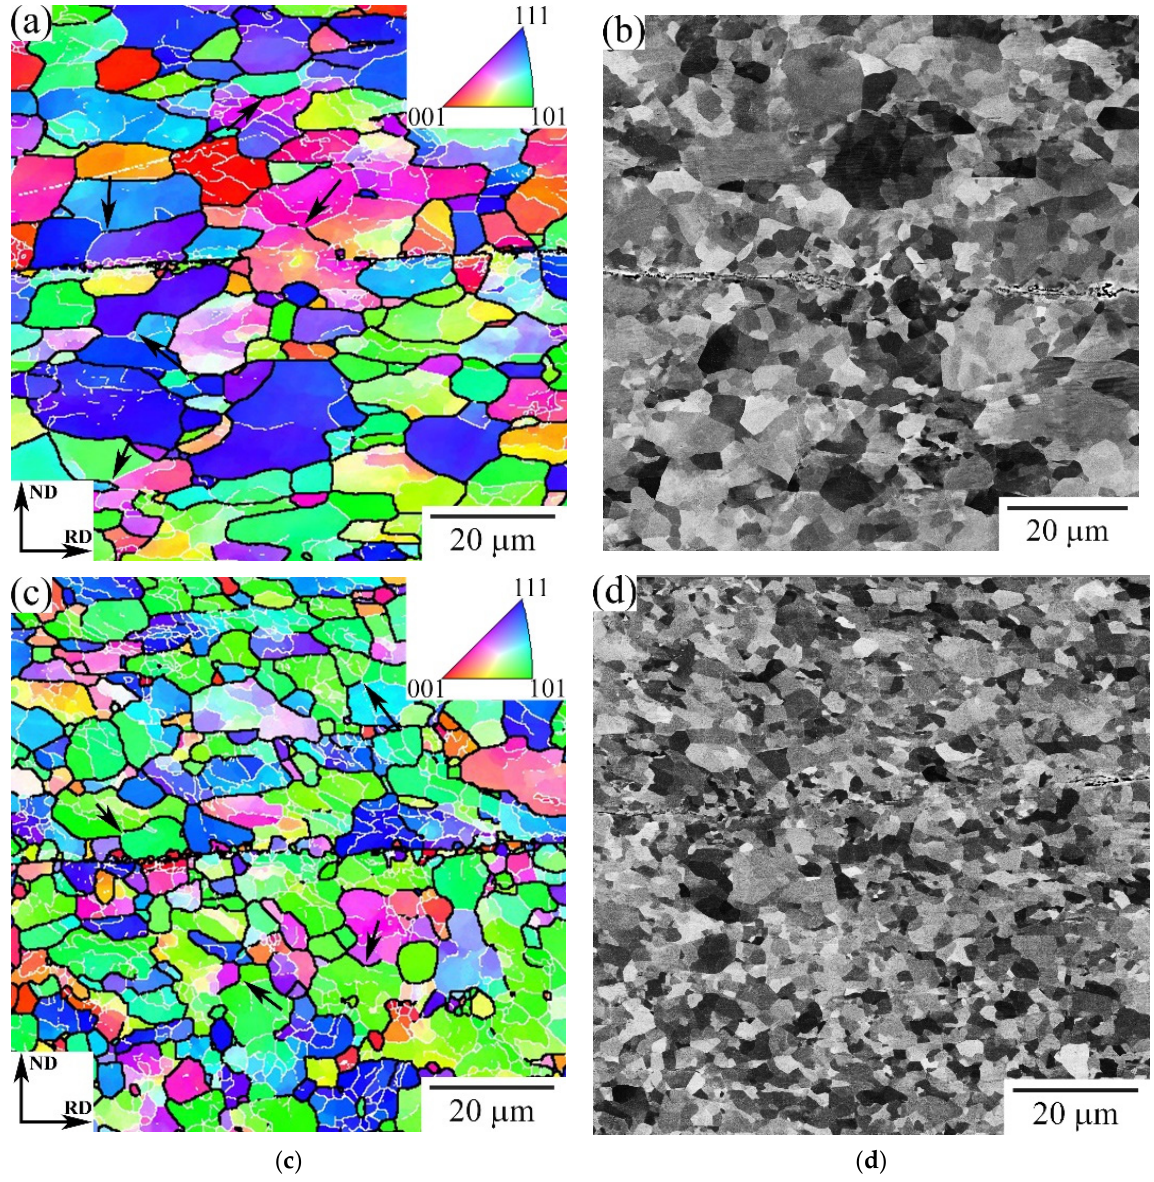
Figure 10. Crystal orientation maps ( a , c ) and BSE images ( b , d ) of ultrasonically welded joints obtained under clamping forces 4.5 kN ( a , b ) and 6 kN ( c , d ) from the samples with initial UFG microstructure.